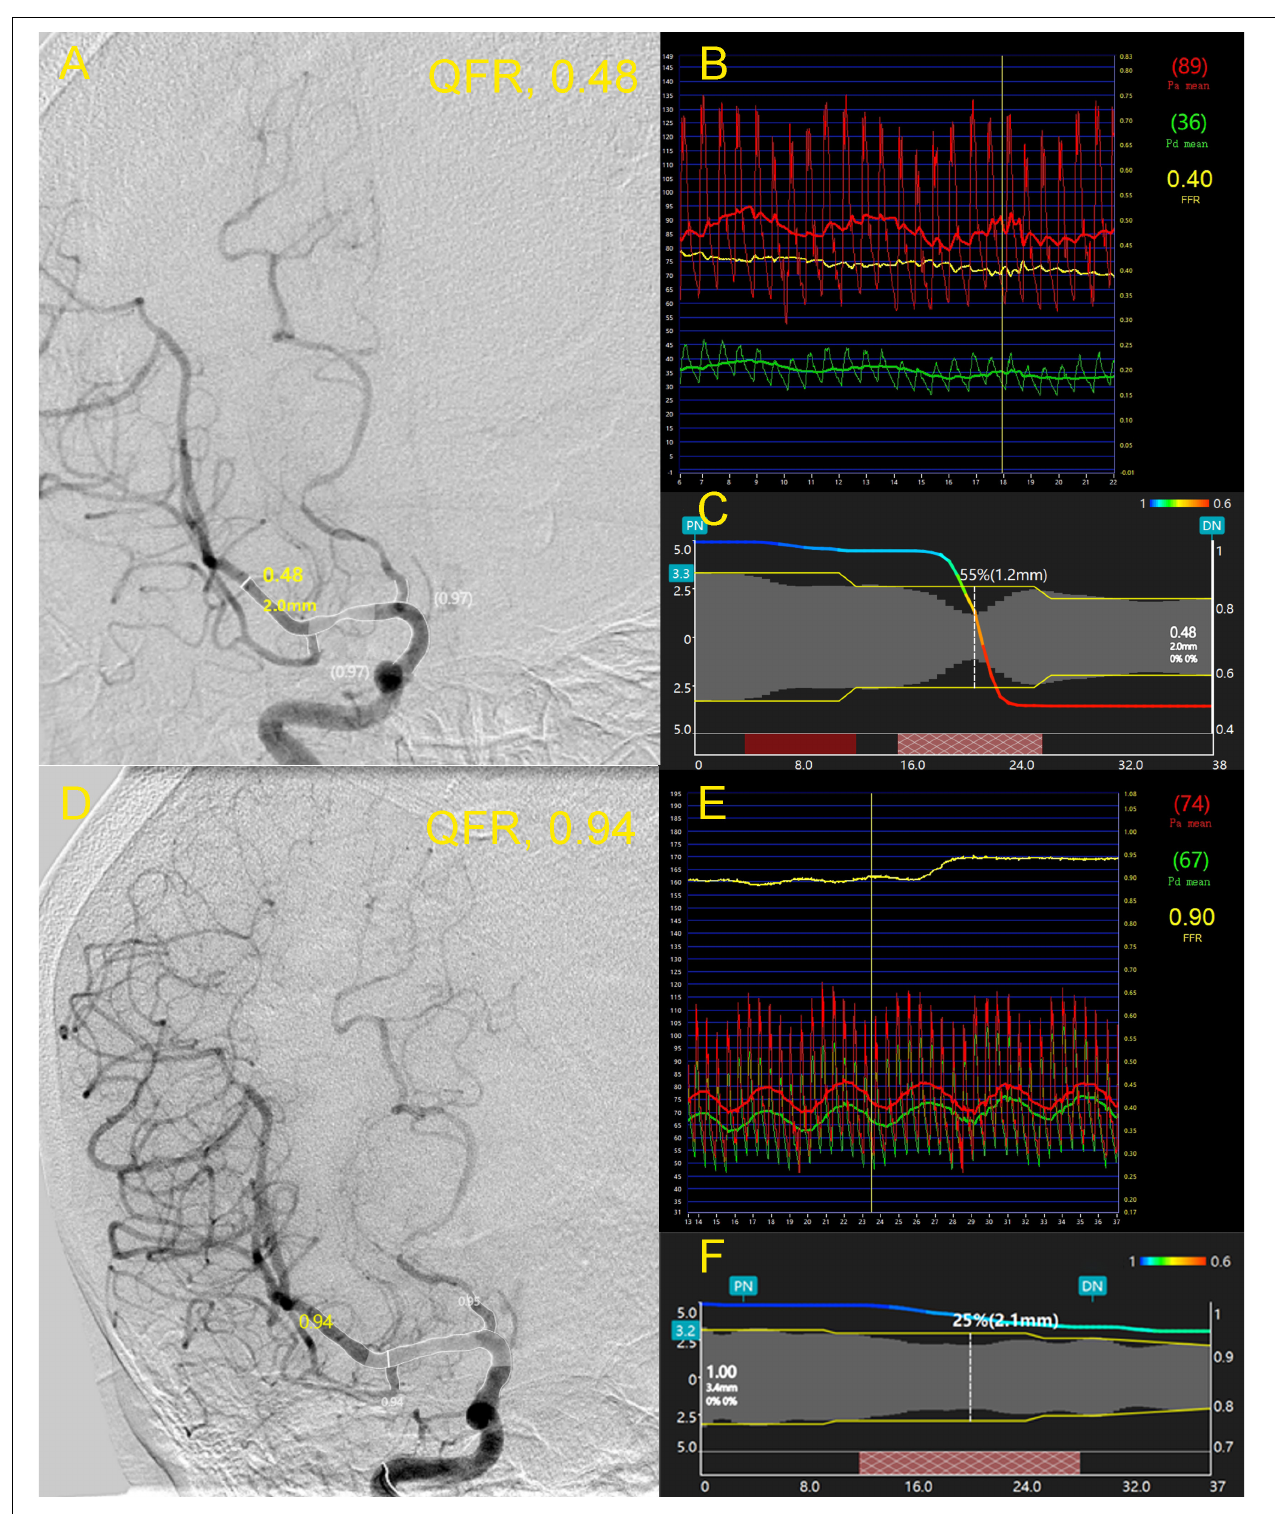
FIGURE 1 | A 63-year-old female was admitted due to newly developed left limb weakness and numbness. Panel (A) shows an intermediate lesion (white arrow) at the right middle cerebral artery (MCA). The wire-based fractional pressure ratios (FPRs) were 0.40 (B) while the computed quantitative flow ratio (QFR) at the lesion was 0.48 with a remarkable pressure drop (C) . After stenting, the stenosis of the right MCA was relieved efficiently (D) . FPR increased to 0.90 (E) and the computed QFR was also up to 0.94 with a minor pressure drop (F) . FPR, fractional pressure ratio; QFR, quantitative flow ratio; MCA, middle cerebral artery.